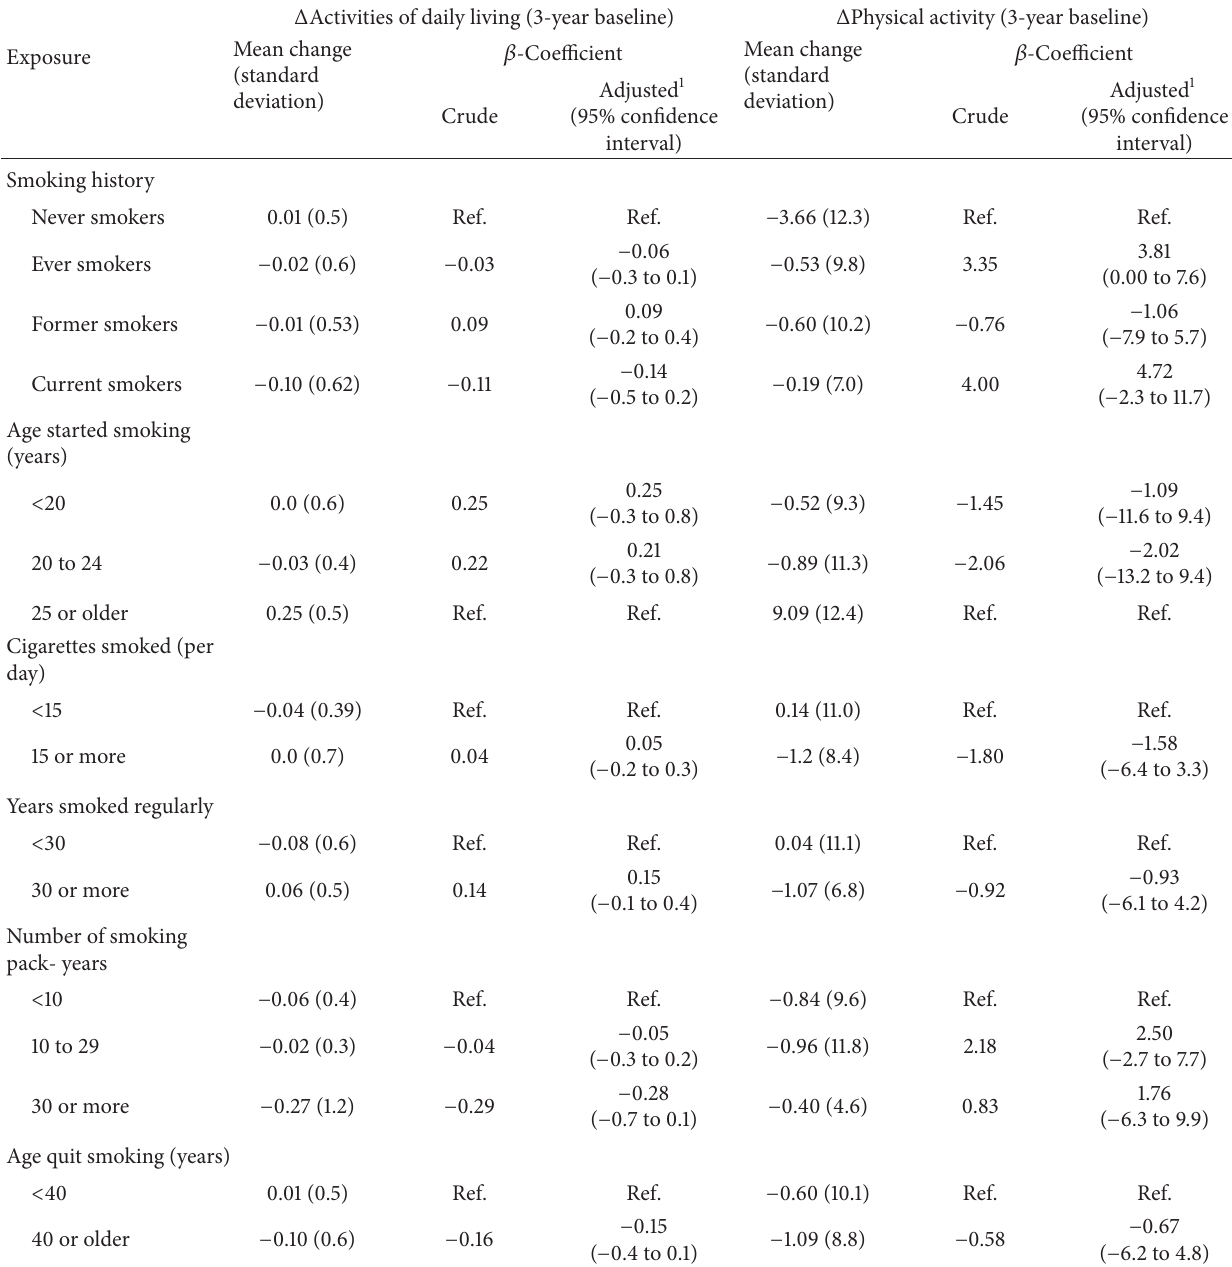
Table 3: Association between smoking status and change in physical functioning and activity scores over 3 years among postmenopausal women with multiple sclerosis in the Women’s Health Initiative Observational